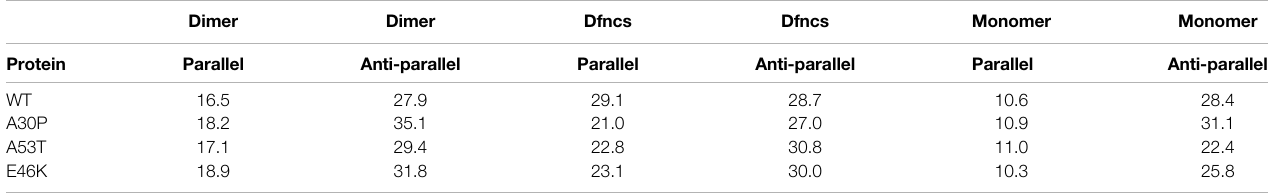
TABLE 2 | Percentages of residues in parallel and anti-parallel intra- and intermolecular β -sheets computed with CUTABI for the ensemble of dimers, the sub-ensemble of Dfncs, and isolated monomers. Dimer Dimer Protein